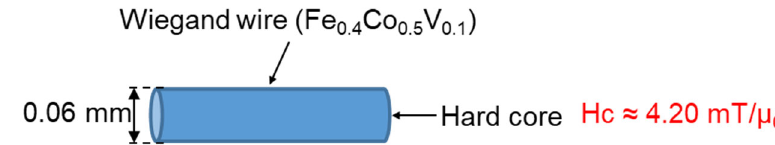
Figure 7. Single magnetic structure diagram.